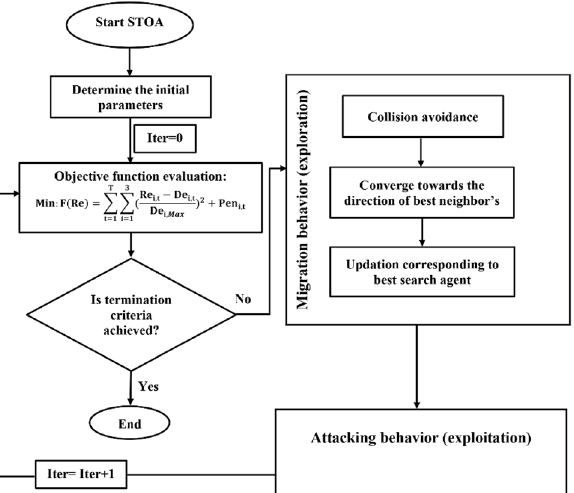
Figure 4. Flowchart of STOA algorithm in the optimal operation of Halilrood multi-reservoirs